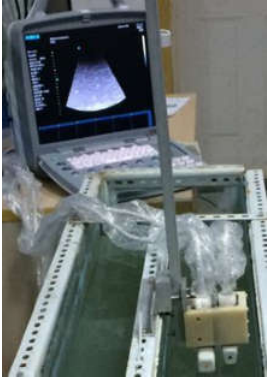
Figure 7. The physical model system for all the experiments.